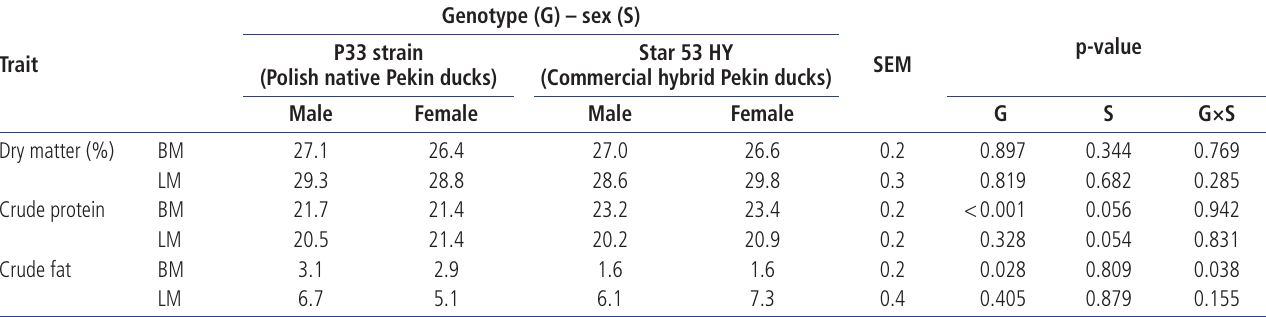
Table 4. Basic chemical composition of breast and leg meat from 49-d-old Pekin ducks of different genotypes